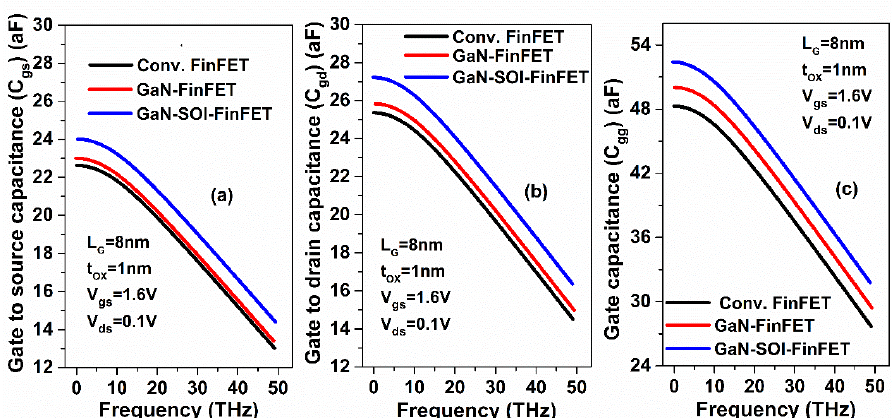
Figure 6. Parasitic capacitances ( a ) C gs , ( b ) C gd , and ( c ) C gg ; plots against high frequencies (THz) for Conv. FinFET and GaN-SOI-FinFET.